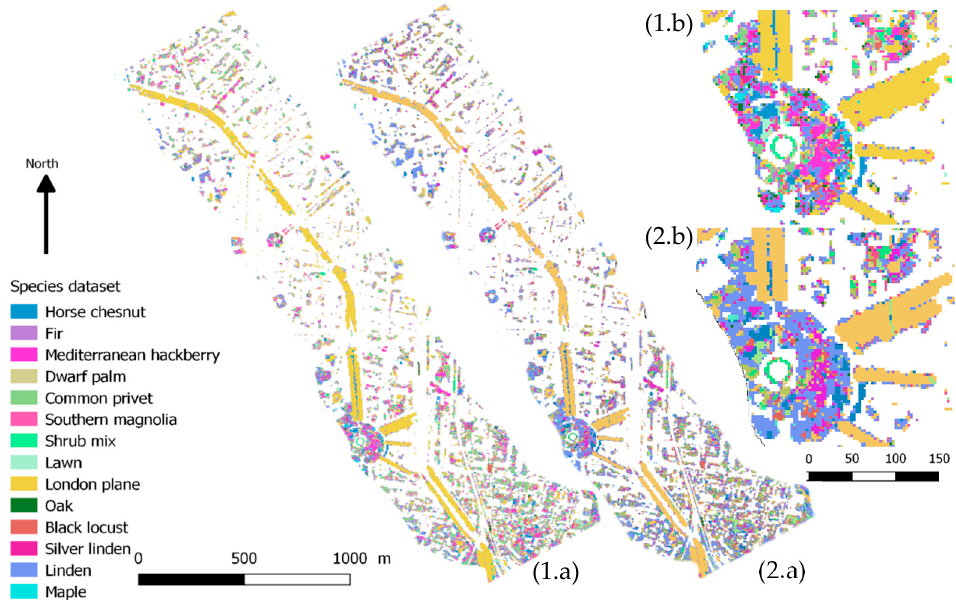
Figure 6. SVM classification of trees species (“14 Species” dataset) with MNF dimension reduction applied on HYPXIM at 4 m. ( 1.a ) 2-folds method and ( 1.b ) Zoom on Grand-Rond roundabout; ( 2.a ) 10-folds method and ( 2.b ) Zoom on Grand-Rond roundabout.